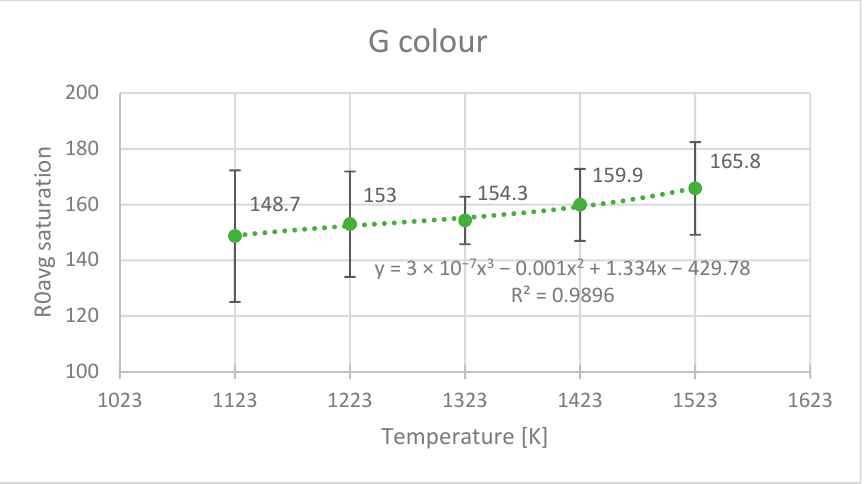
Figure 14. Mean R0 saturation of the G colour. (Reprinted with permission from Ref . [8]. 2022, AFIT.)